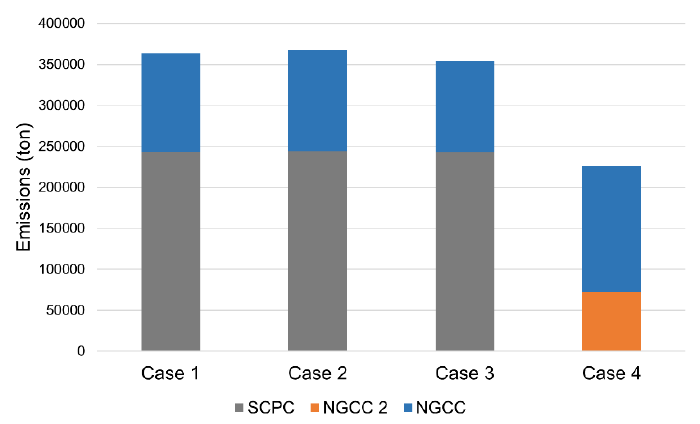
Figure 14. CO 2 equivalent emissions by case study.